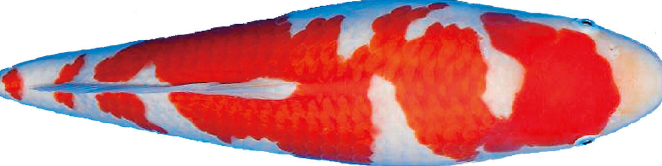
Figure 1. Example of cropping and background removal. The blue hue in the image is the reflection of the background on the fish scales.